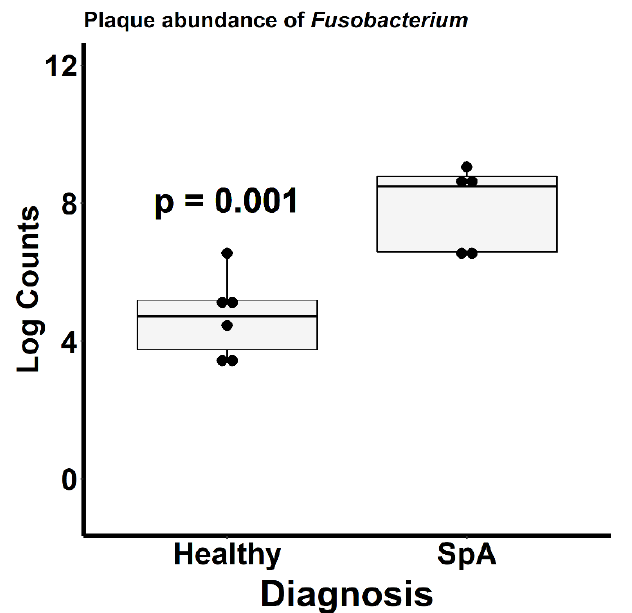
Figure 5. Relative abundance of Fusobacterium within the sub-gingival sulcus of patients with Spondyloarthritis (SpA) and healthy controls.